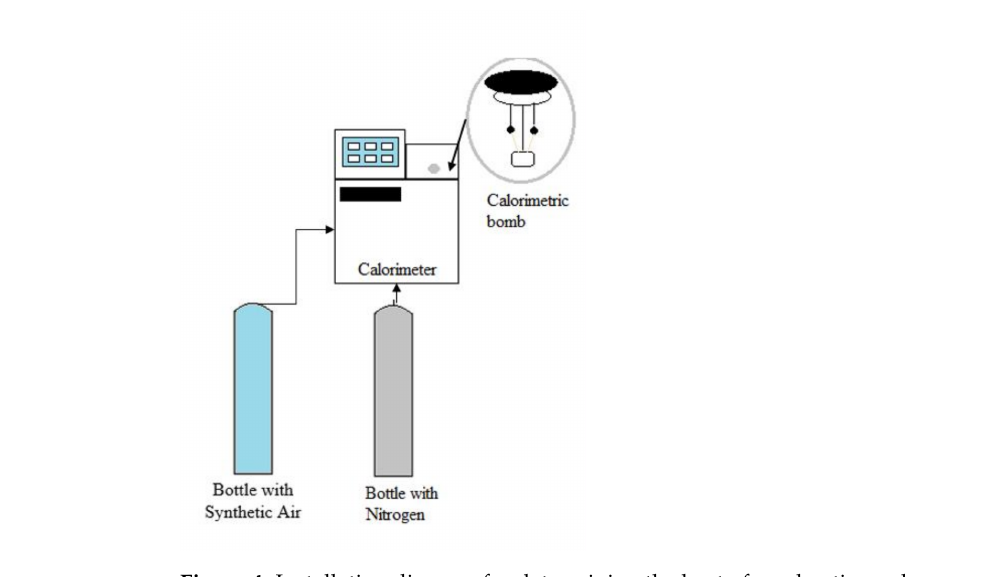
Figure 4. Installation diagram for determining the heat of combustion value.